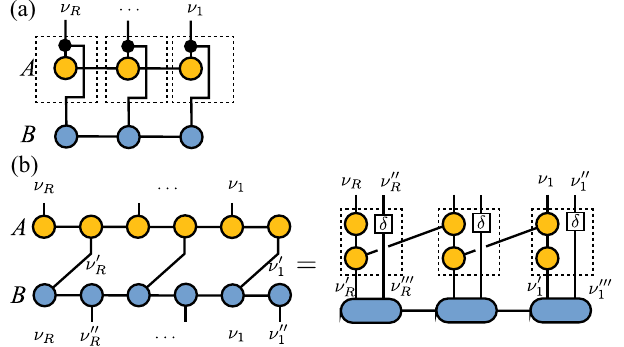
FIG. 5. Tensor contraction for the elementwise product (a) and matrix product (b) of two MPSs A and B . The filled circles in (a) denote a superdiagonal tensor whose nonzero entries are 1. The dashed squares denote the tensors of the auxiliary